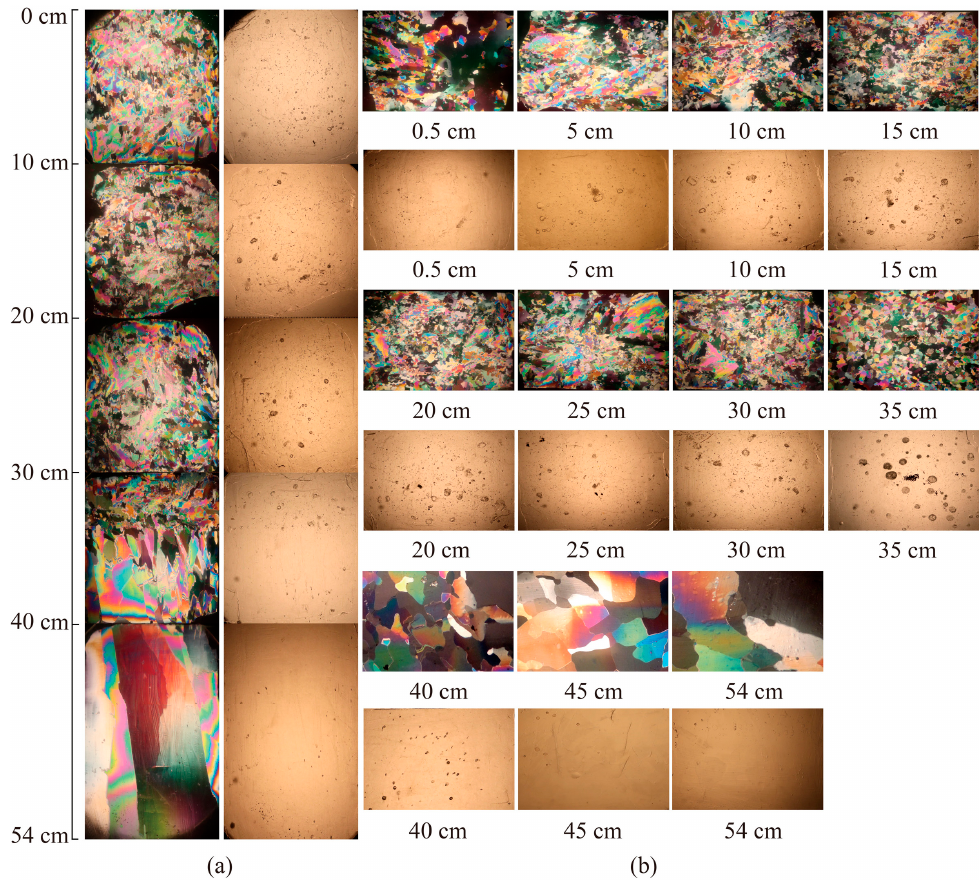
Figure 11. Ice crystal microstructure and the air bubbles in ice at depth of 0–54 cm: ( a ) ice crystal microstructure ( left ) and air bubbles ( right ) in the ice perpendicular to the ice surface; ( b ) ice crystal microstructure ( top ) and air bubbles ( bottom ) in the ice parallel to the ice surface.